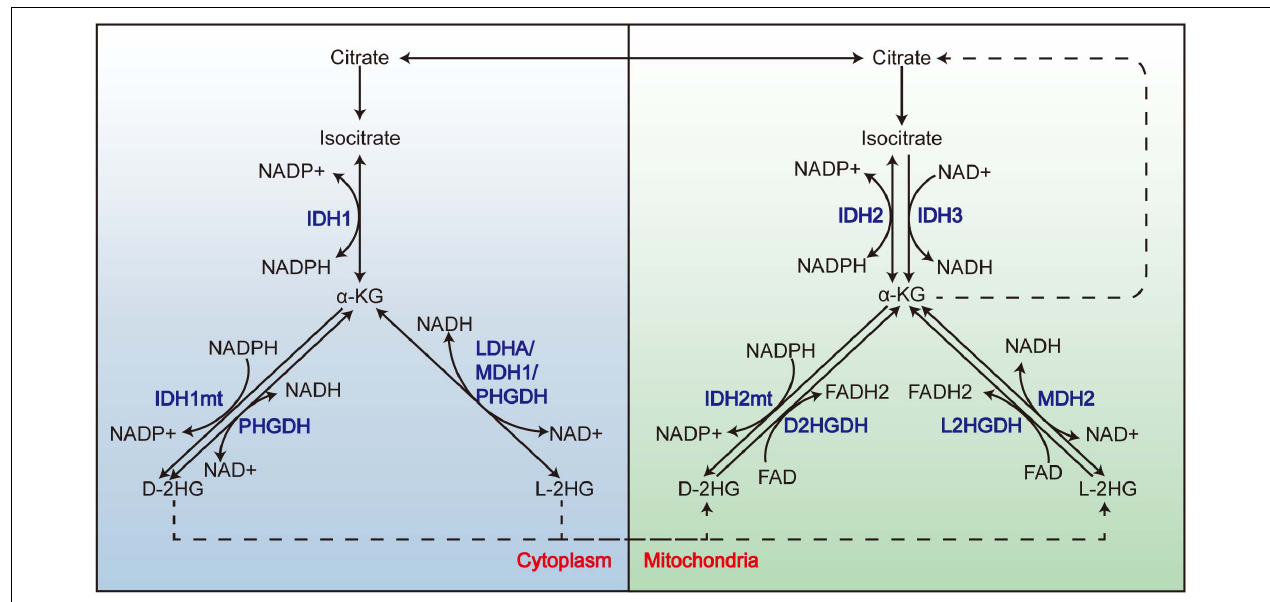
FIGURE 1 | The promiscuity of LDHA, MDH, and PHGDH and the metabolism of 2-HG. 2-HG derives from the promiscuity of LDHA, MDH1, and PHGDH in the cytoplasm and MDH2 in the mitochondria. Mutations of IDH1 and IDH2 endow them the neomorphic enzyme activity to convert α -KG to D -2HG. L -2HG and D -2HG are removed by L2HGDH and D2HGDH from the mitochondria, respectively. LDHA, lactate dehydrogenase A; MDH, malate dehydrogenase; 2-HG,